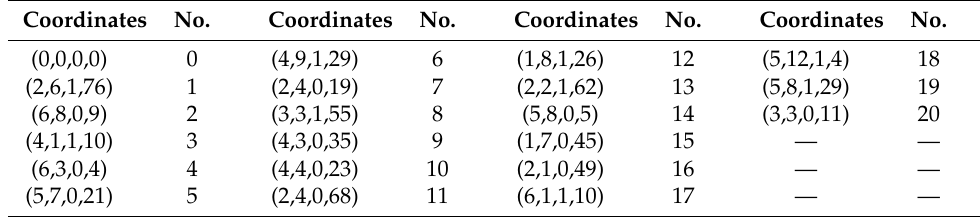
Table 6. Coordinates and number when the number of locations to be visited is 20. Coordinates